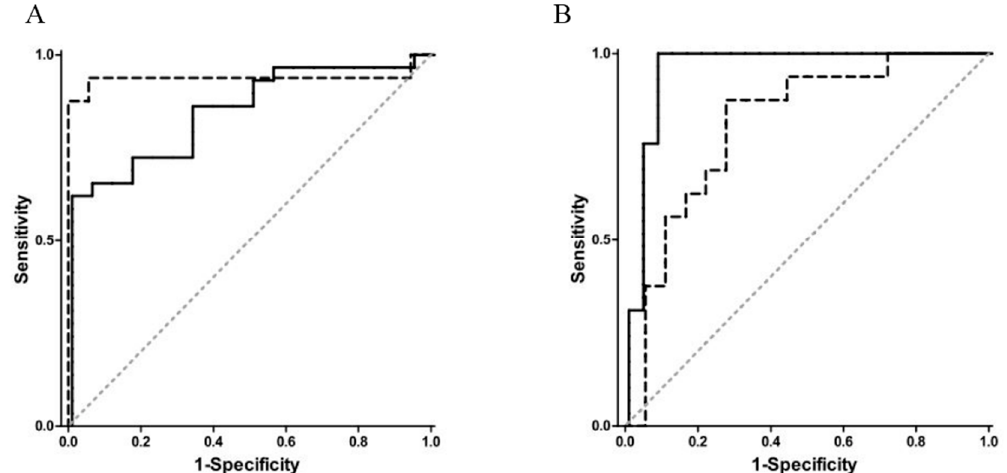
Figure 23. ( A ) Receiver operator characteristic curve for the discrimination of Crohn’s disease and healthy controls at first presentation (solid line) and upon achieving remission (dashed line), by electronic nose. The areas under the curve ± 95% confidence interval (AUC ± 95% CI) with associated p -value were: first presentation 0.85 ± 0.05, <0.001; remission 0.94 ± 0.06, <0.001; ( B ) Receiver operator characteristic curve for the discrimination of ulcerative colitis and Crohn’s disease at first presentation (solid line) and upon achieving remission (dashed line), by electronic nose. The areas under the curve ± 95% confidence interval (AUC ± 95% CI) with associated p -value were: first presentation 0.96 ± 0.03, <0.001; remission 0.81 ± 0.08, 0.004. Used with permission from [51].